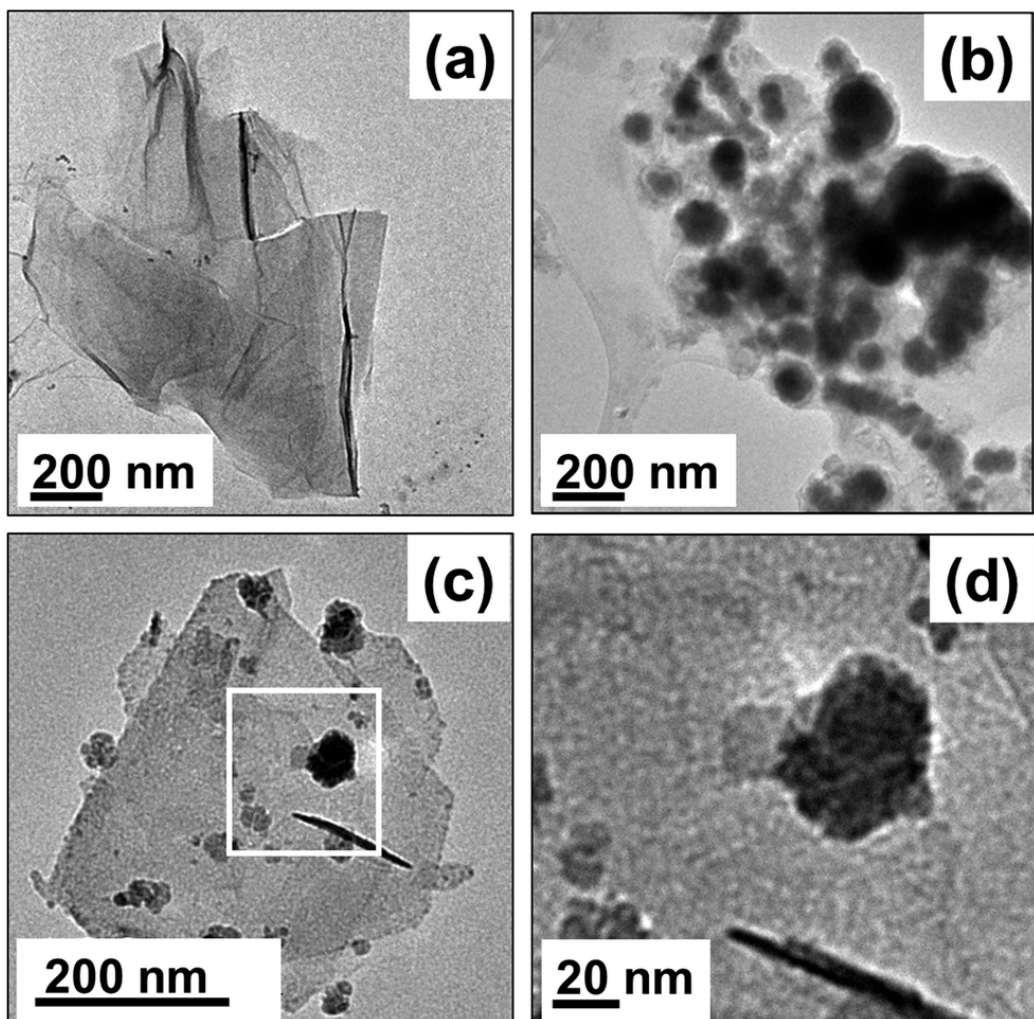
Figure 8. TEM images of ( a ) rGO, ( b ) nZVI, ( c ) and ( d ) rGO–nZVI NHs [67].